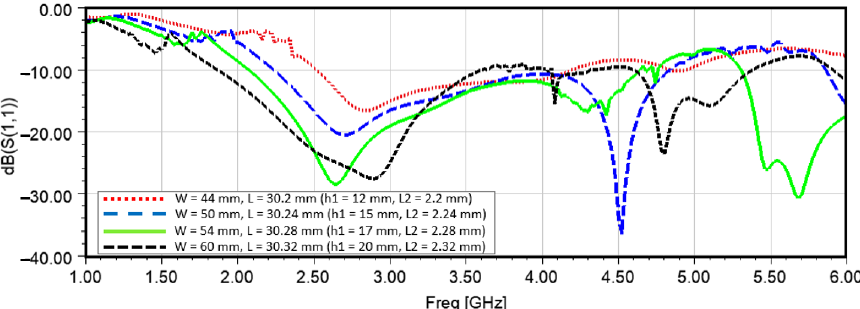
Figure 17. Effect of varying the width on the reflection coefficient of the proposed antenna 2.